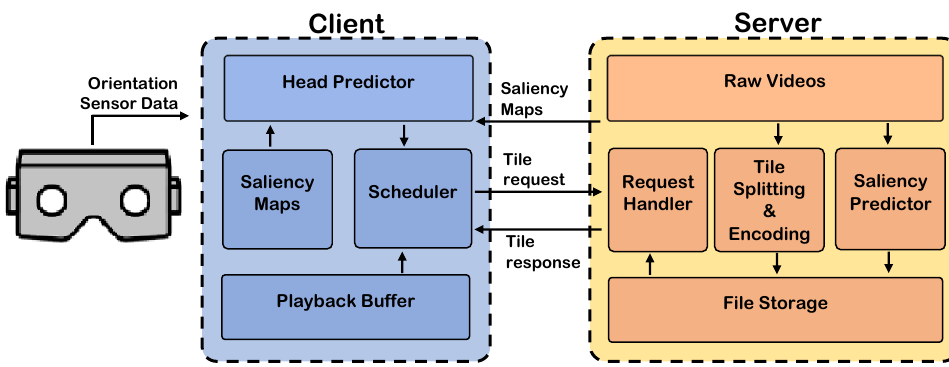
Figure 1. The proposed saliency-based 360 video streaming